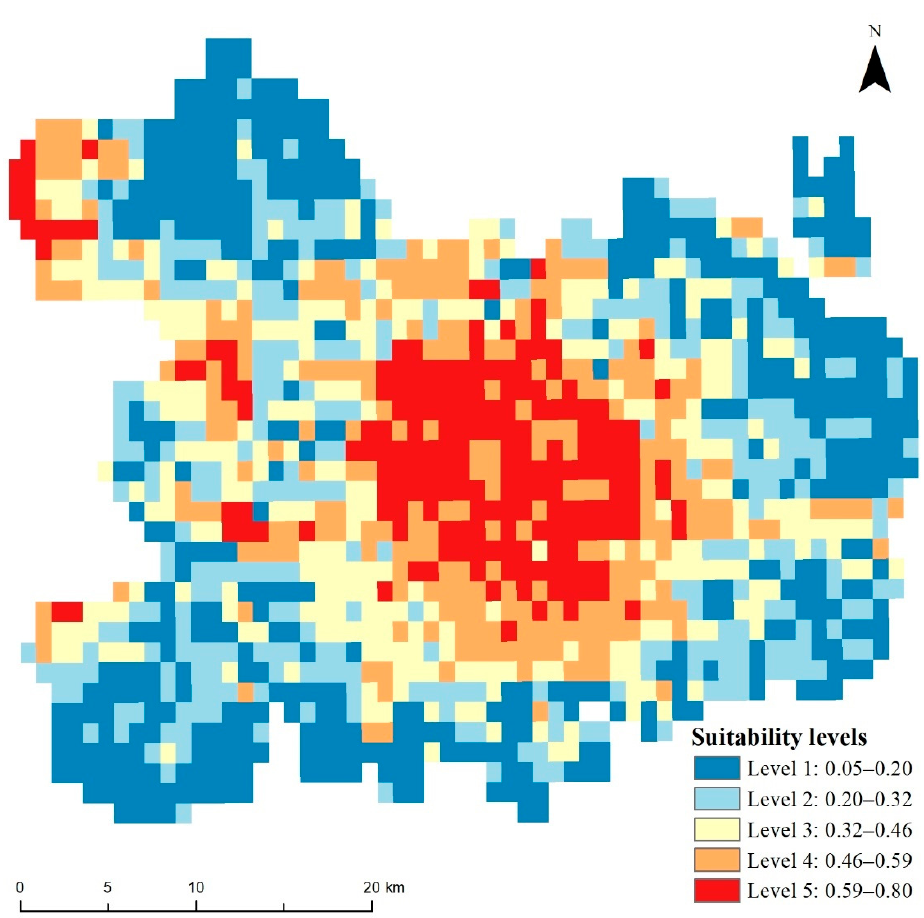
Figure 7. Running suitability map based on maximum entropy model prediction.